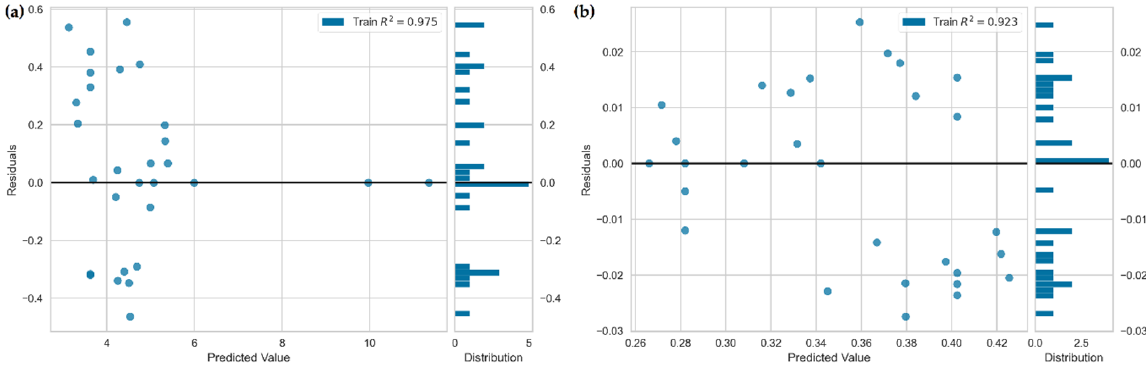
Figure 12. Residuals versus AdaBoost regression predicted ( a ) MRR ( b ) Kerf.